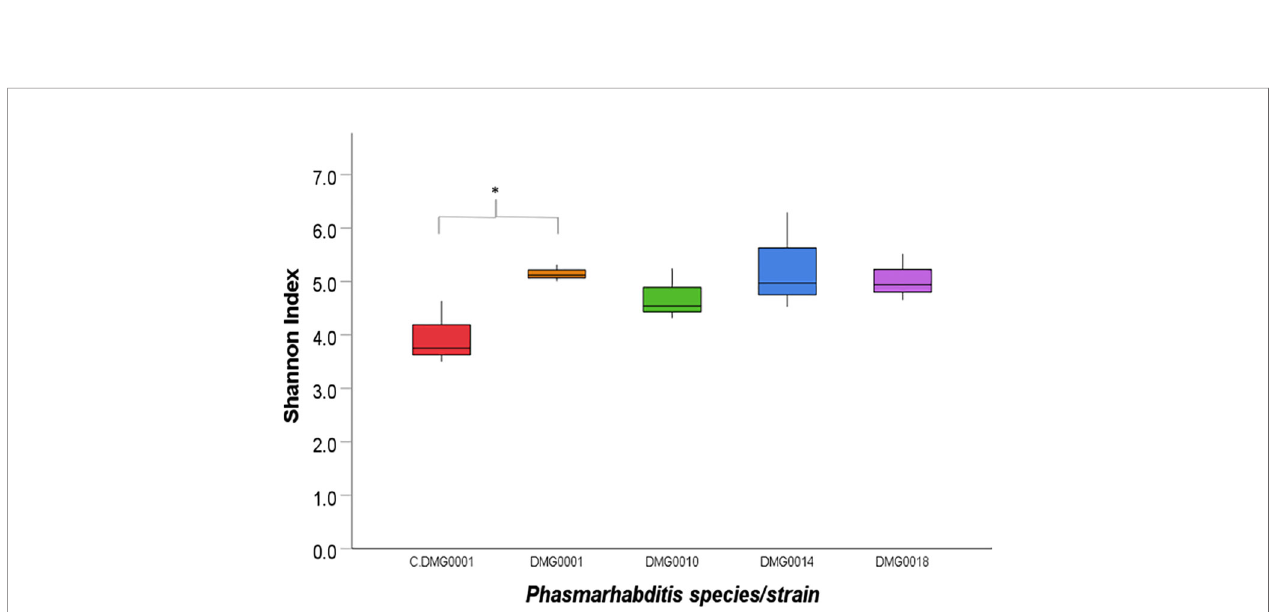
FIGURE 4 | Shannon index of diversity indicates the level of diversity of bacteria found in P. hermaphrodita (C.DMG0001, DMG0001, DMG0010), P. californica (DMG0018) and P. neopapillosa (DMG0014). The lowest diversity was found in P. hermaphrodita C.DMG0001. Higher diversity can be seen from nematodes that have killed a slug host: P. hermaphrodita (DMG0001 and DMG0010), P. neopapillosa (DMG0014) and P. californica (DMG0018). * means P <